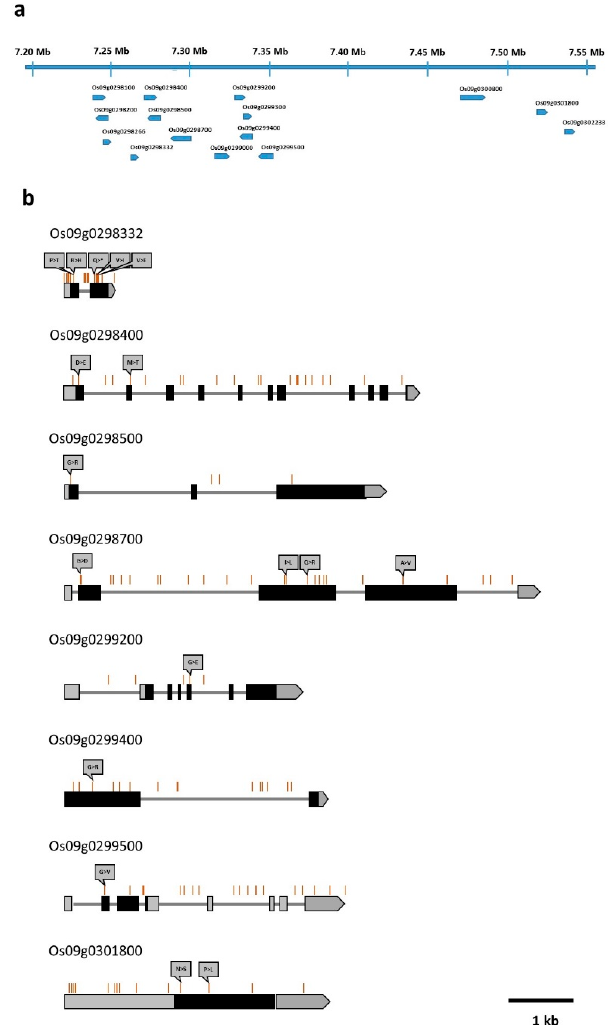
Figure 4. A physical map showing the location of genes in the qFfR9 region and the distribution of DNA polymorphisms in the candidate genes contained in the qFfR9 region. ( a ) A physical map showing the location of genes in the qFfR9 region; ( b ) the distribution of DNA polymorphisms in the candidate genes contained in the qFfR9 region. The locations of DNA polymorphisms are indicated by brown vertical lines. Filled gray boxes indicate 5’ and 3’ untranslated regions (UTRs), and filled black boxes indicate exons, including protein-coding sequences. Gray lines indicate introns. Changes in amino acids are indicated over non-synonymous single nucleotide polymorphisms (SNPs).